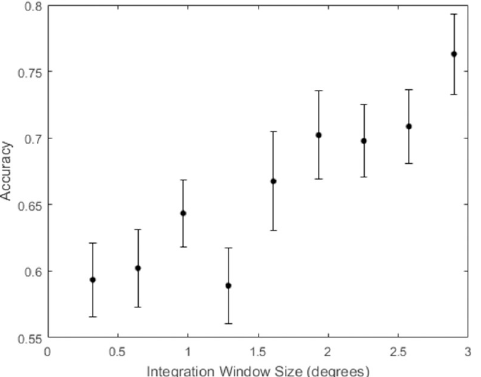
Fig 10. Experiment 2 results with a constant curvature target. The error bars reflect ± one standard error of the